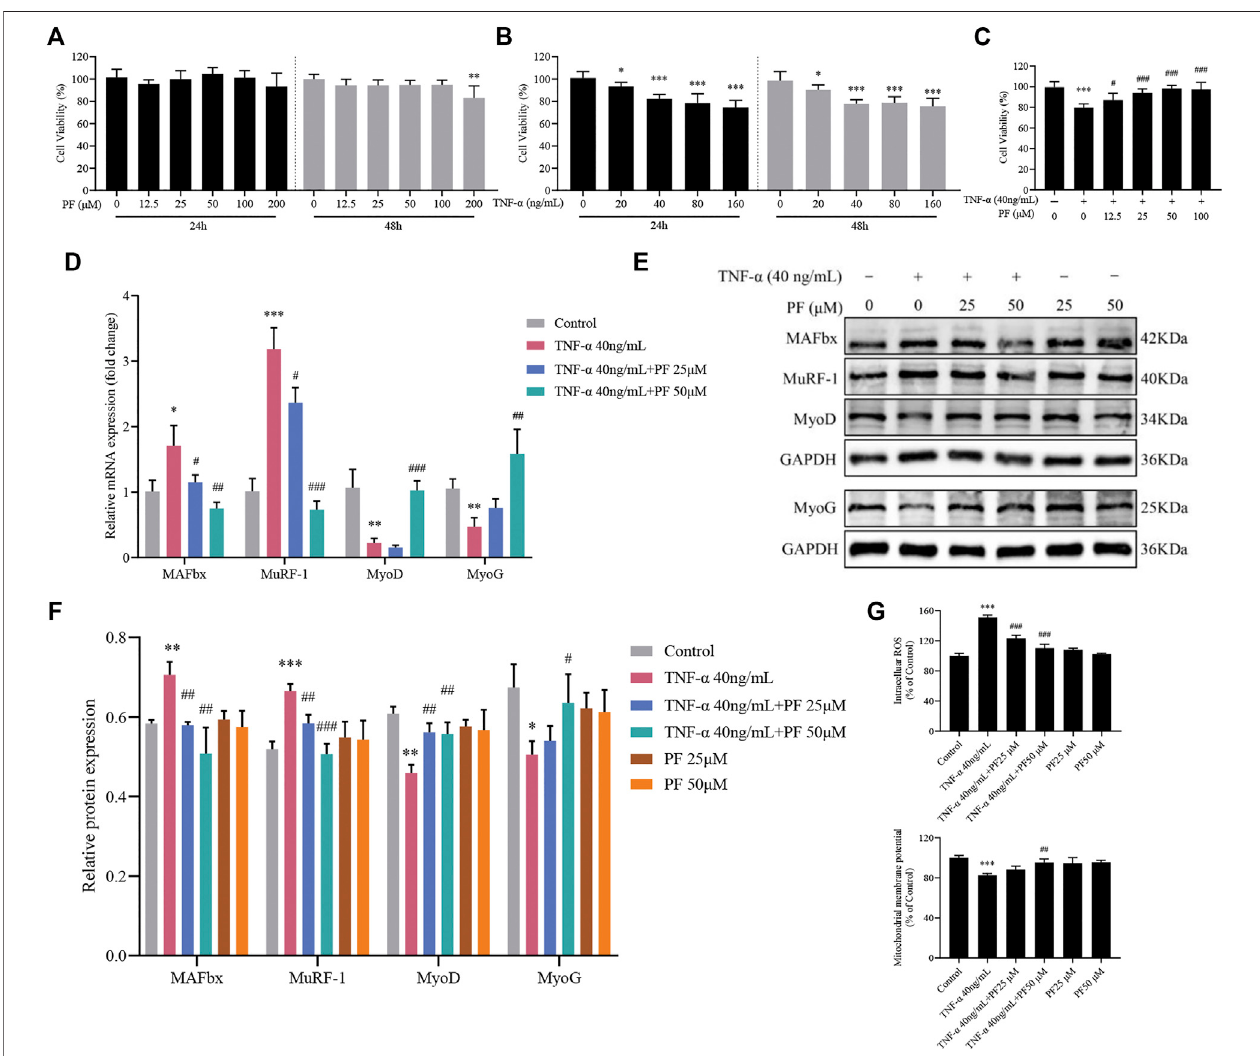
FIGURE 6 | PF suppressed TNF- α -induced C2C12 myoblast damage. (A) C2C12 myoblasts were treated with TNF- α (0, 20, 40, 80 and 160 ng/ml) for 24 and 48 h. (B) CytotoxicityofPF(0,12.5,25,50,100and200 μ M)for24and48 h. (C) Cellsweretreatedwith40 ng/mlTNF- α and12.5,25,50,and100 μ M PFfor48 h.Cell viability was measured with a CCK-8 assay ( n = 6). * p < 0.05, ** p < 0.01, *** p < 0.001 compared with PF 0 μ M or TNF- α 0 ng/ml. # p < 0.05, ## p < 0.01, ### p < 0.001 compared with the 40 ng/ml TNF- α group. (D) The expression of MAFbx, MuRF-1, MyoD and myoG was determined by RT – qPCR. (E) Representative western blots using antibodies against MAFbx, MuRF-1, MyoD, MyoG and GAPDH. (F) Quanti fi cation of protein expression. (G) PF inhibited intracellular ROS generation and increased Δψ minC2C12cells.AllproteinexpressionwasnormalizedtothatofGAPDHasaloadingcontrol.Thedataarepresentedasthemeans±S.D. n =3,* p < 0.05, ** p < 0.01, *** p < 0.001 compared with the Control group. # p < 0.05, ## p < 0.01, ### p < 0.001 compared with the TNF- α 40 ng/ml group.